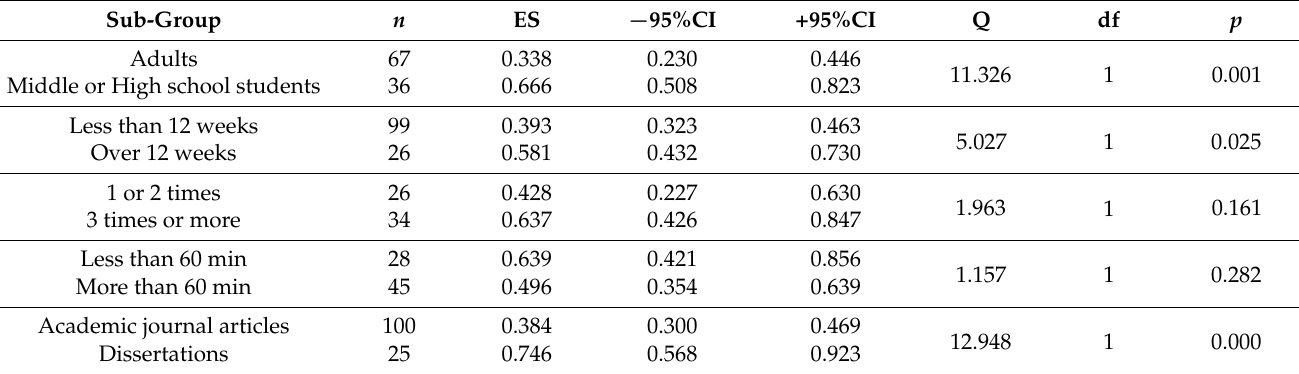
Table 5. Sub-group